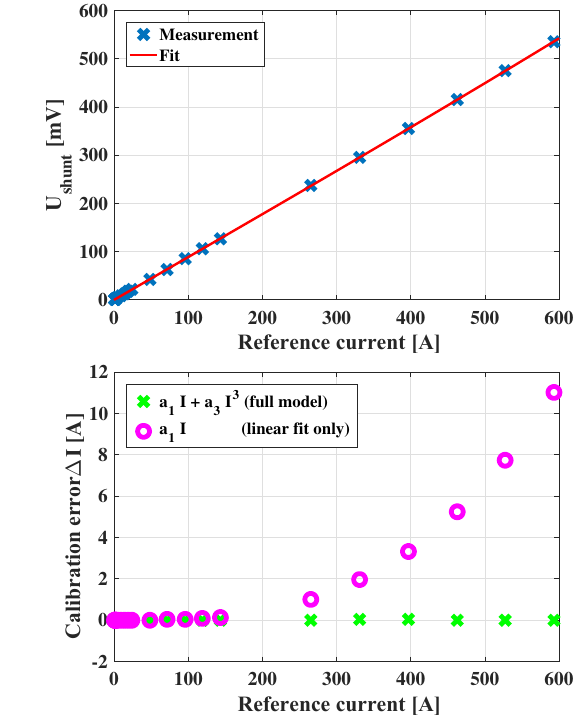
Figure 6. Calibration measurement and resulting error for T amb = 20 ◦ C and thermal steady state. The error of the proposed nonlinear model is below 20mA, whereas the error for the linear fit (without self-heating effects) exceeds 10A.